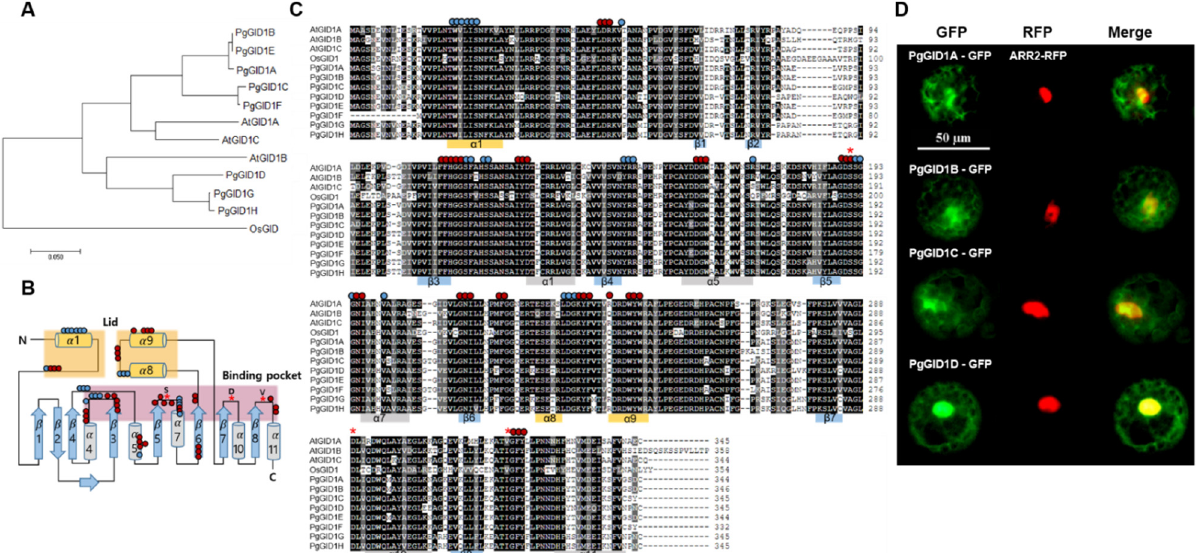
Figure 2. Phylogenetic analysis and amino acid sequence alignment of GID1 proteins. ( A ) Phylogenetic analysis of PgGID1A–H, AtGID1s, and OsGID1. The phylogenetic tree was constructed using the MEGA7 program. Horizontal branch lengths are proportional to the estimated number of amino acid substitutions per residue. Bootstrap values were obtained by 1000 bootstrap replicates. Pg, Panax ginseng ; At, Arabidopsis thaliana ; Os, Oryza sativa . ( B ) Topology diagram based on the predicted secondary structure of the OsGID1 protein [15]. (Blue circles indicate important residues involved in the GID1–SLR1 interaction, and red dots indicate important residues involved in OsGID1–GA and GID1–SLR1 interactions. Red stars indicate residues essential for enzymatic activity. Colored zones indicate the lid (yellow) and binding pocket (red). ( C ) Amino acid sequence alignment of the GID1 proteins of Arabidopsis , rice, and P. ginseng constructed using SMS (https://www.Bioinformatics.org (accessed on 1 May 2021)). ( D ) Subcellular localization analysis of PgGID1A–D proteins in Arabidopsis protoplasts. Full-length coding sequences of PgGID1A–D were fused to the GFP reporter gene. The nucleus was visualized using the AtARR2-RFP nuclear marker. GFP and RFP fluorescence images were merged. Scale bar = 50 μ m.